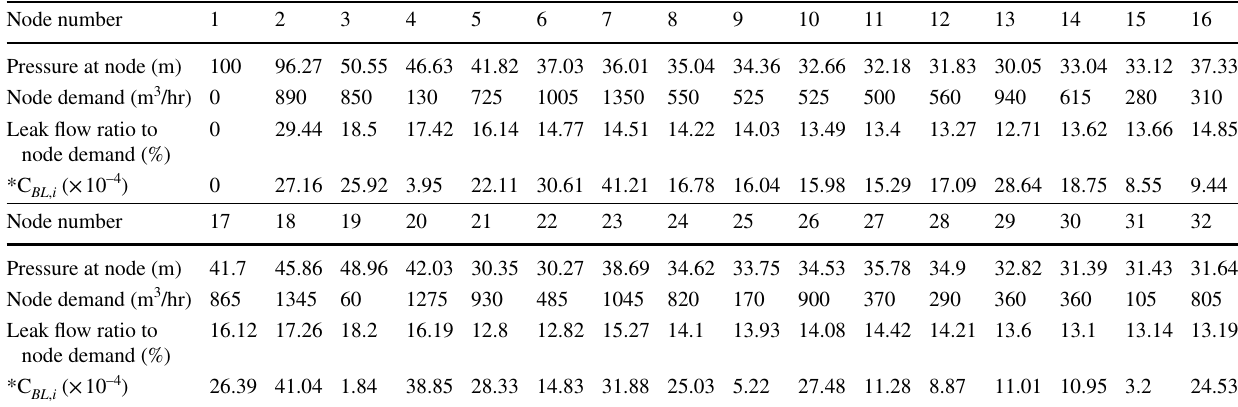
Table 9 Optimal pressure calculated by the NSGA-II model for three-loop pressure-dependent leakage Hanoi WDN